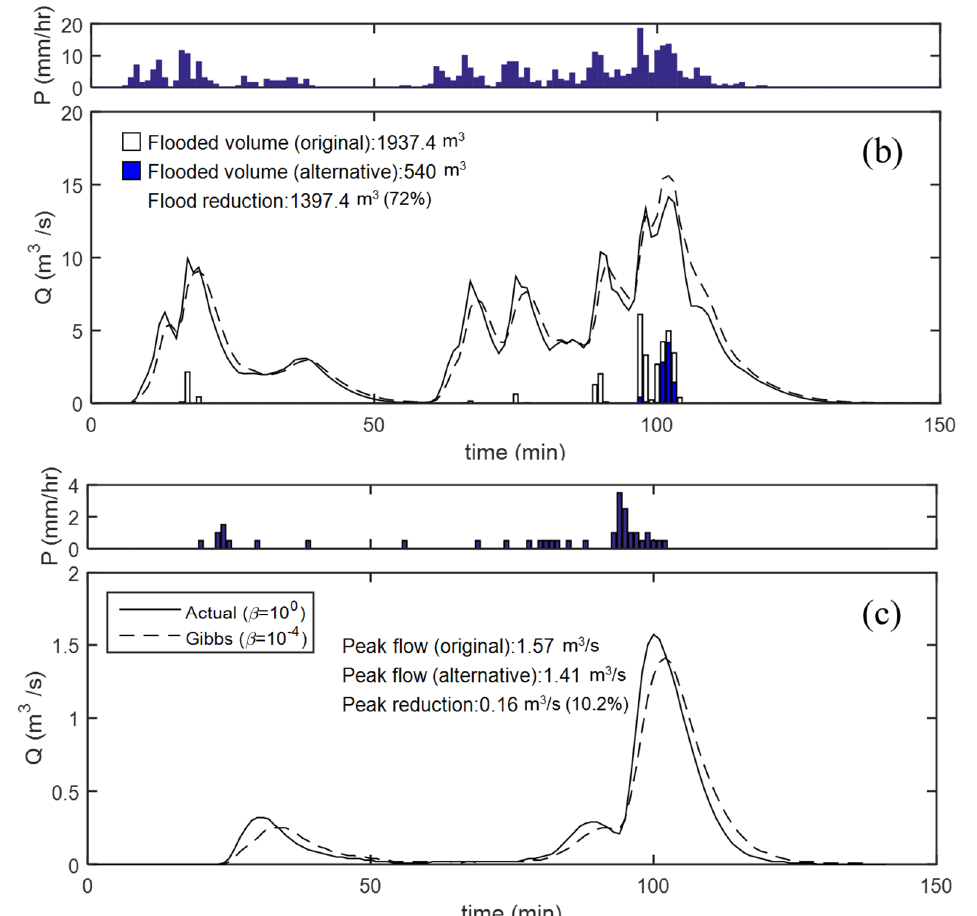
Figure 8. Simulation results with actual and alternative layout from Gibbs’ model for storm events on ( a ) 21 September 2010; ( b ) 26 July 2011; ( c ) 23 July